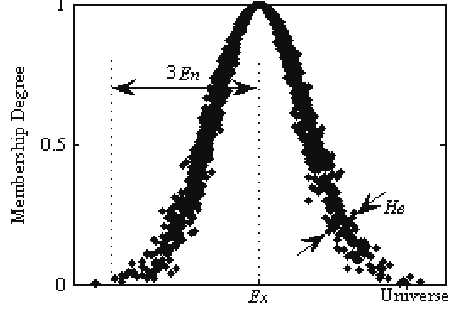
Figure 1. Illustration of a normal cloud The cloud with n drops is generated by the basic normal cloud generator [3].